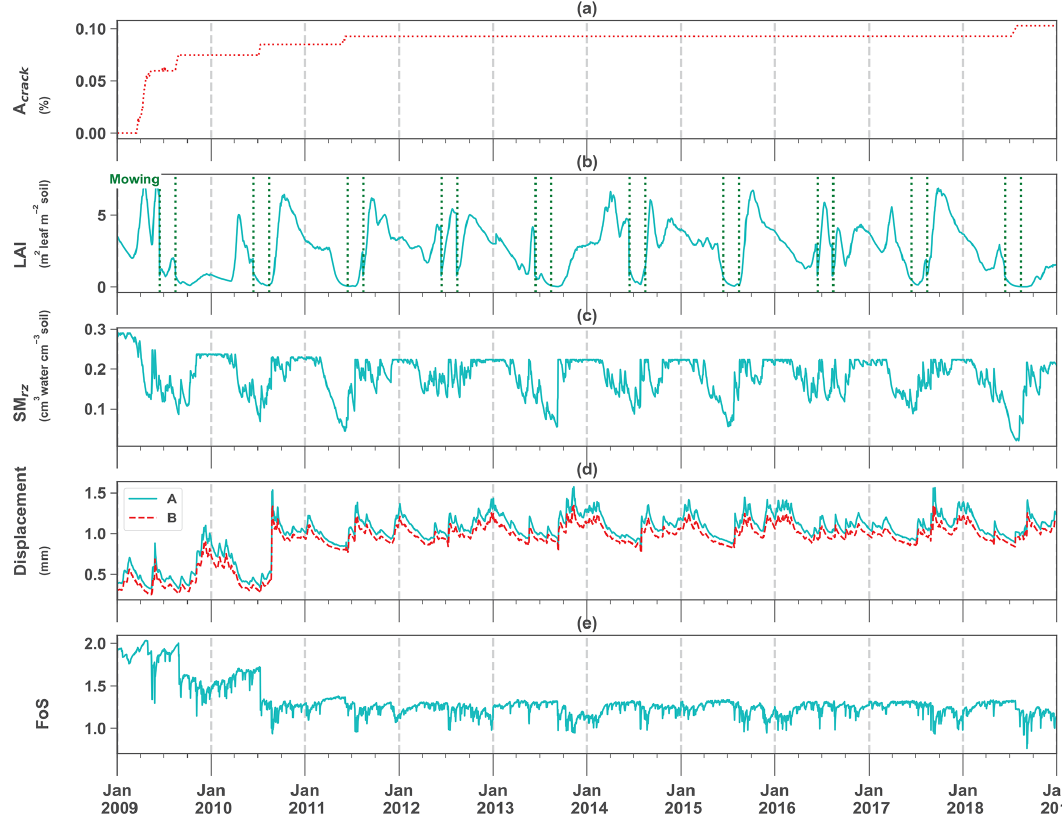
Figure 3. Daily values of selected outputs for two models from 2009 to 2019. (a) Crack area; (b) Leaf Area Index (LAI); (c) root zone soil moisture (SM rz ); (d) displacement at locations A and B shown in Fig. 1; (e) Factor of Safety (FoS) (after Jamalinia et al.,